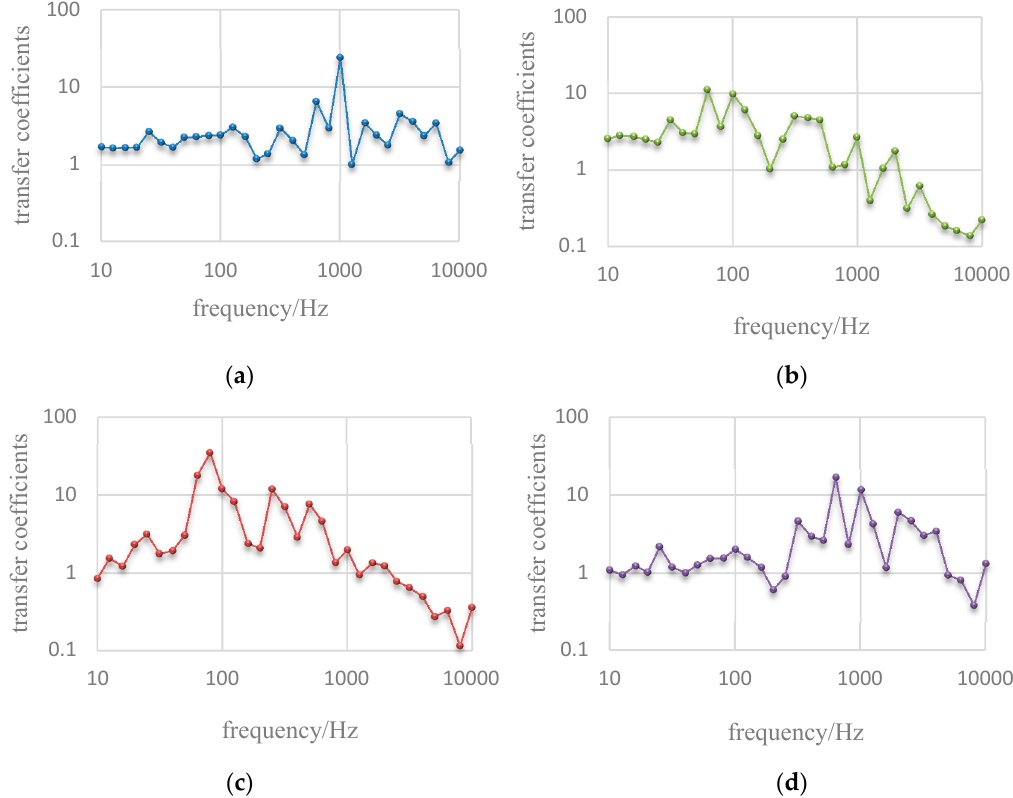
Figure 11. Test results under 2300 r/min: ( a ) SLMB; ( b ) DLMB; ( c ) BCR and ( d ) RP. Coatings 2020 , 10 , x FOR PEER REVIEW